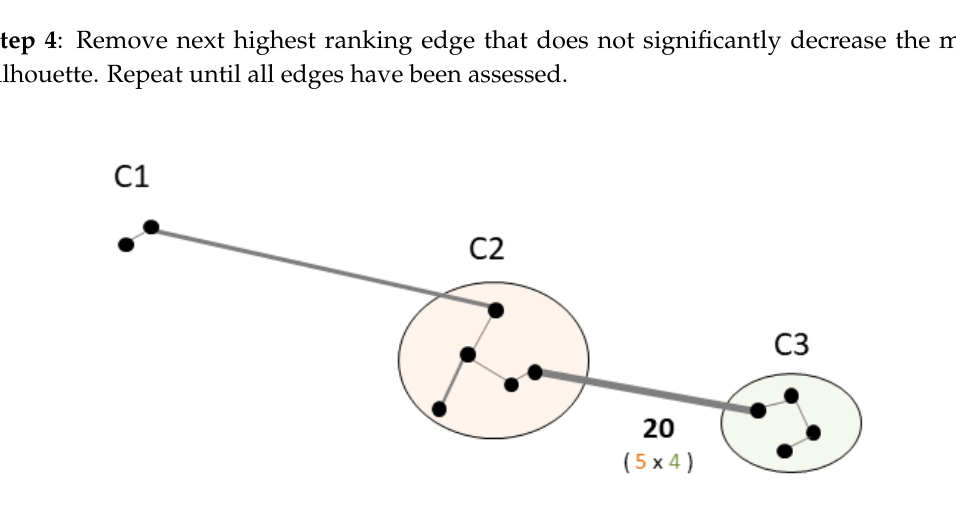
Figure 2. Illustration of the concept of minimax bridgeness with three clusters C1 (2 points), C2 (5 points) and C3 (4 points). The weight of the edge separating C3 from C2 is the minimax distance between any point in C3 to any point in C2 and vice-versa. The minimax bridgeness of that edge is the number of paths on which it has the largest weight: β ( E C 2 − C 3 ) = 20.